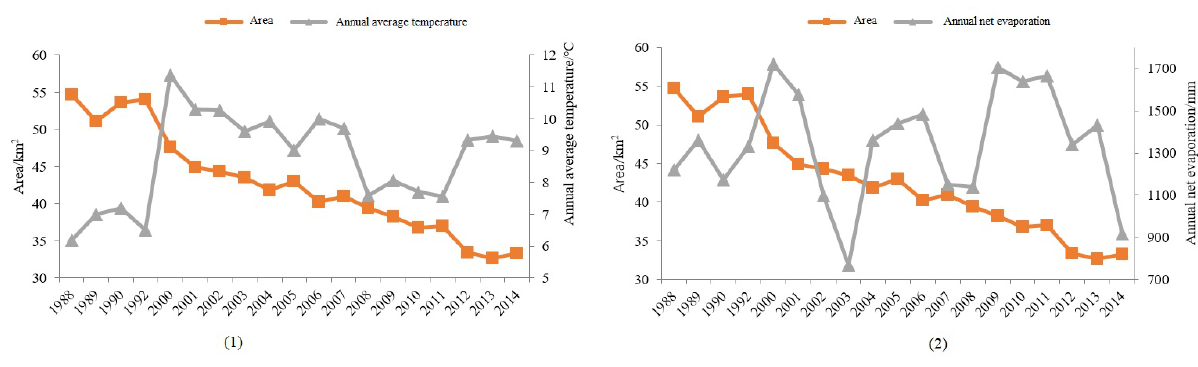
Figure 2. Comparison of area of Hongjiannao Lake and (1) annual average temperature (2) annual net